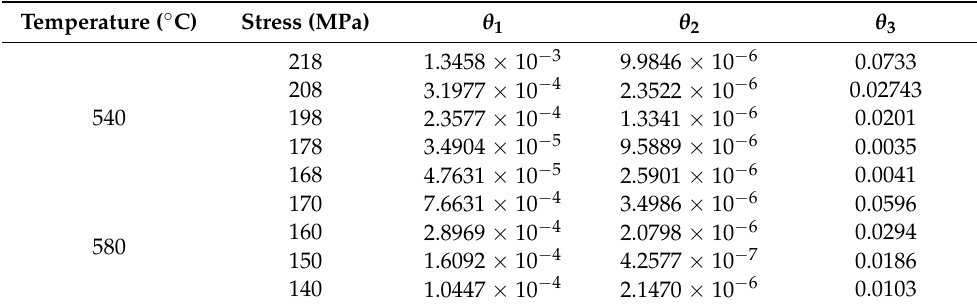
Table 7. The values of θ i at different stress levels at 540 ◦ C and 580 ◦